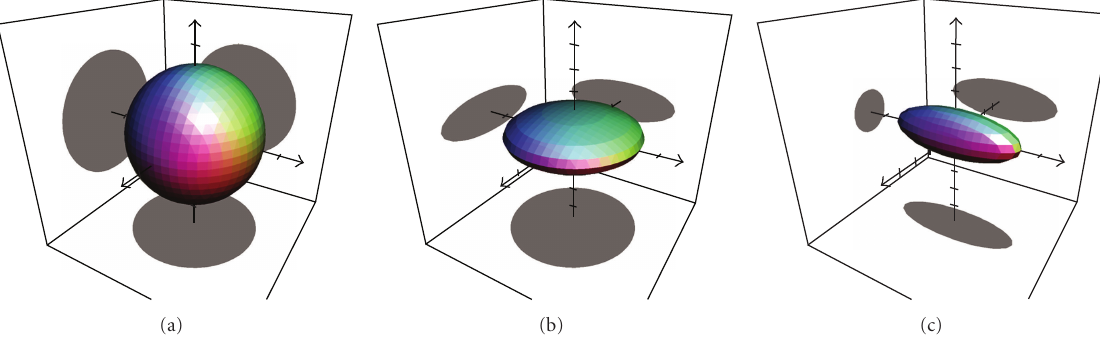
Figure 1: This illustrates the basic tensor shapes of di ff usion tensor imaging (DTI). If the di ff usion is not restricted, the resulting tensor is a sphere (a). If the di ff usion is restricted in only one direction, the resulting tensor is lens-shaped (b). If the di ff usion is restricted in two directions, the resulting tensor is cigar-shaped